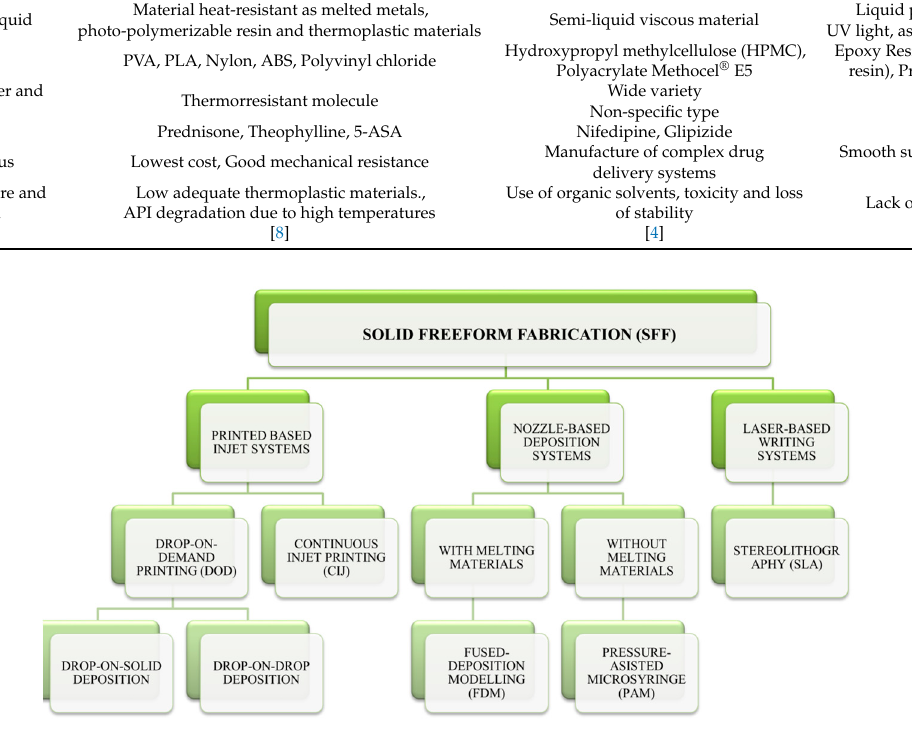
Figure 2. 3D printing technologies for medicine manufacture. Modified from reference [4].